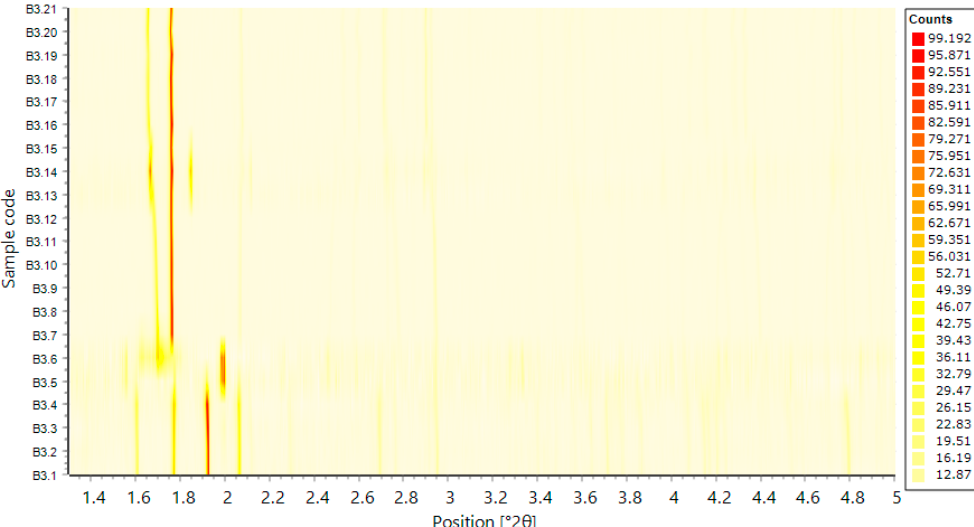
Figure 11. Surface plot of XRPD profiles of HI in the presence of 4-bromoresorcinol corresponding to the P 2 1( γ ) (pH: 4.87 to 5.60), P 2 1( δ ) (pH: 5.60 to 5.71) and P 2 1( β ) (pH: 5.91 to 8.10) polymorphs. The vertical axis corresponds to particular sample codes, the horizontal axis to a specific 2 θ range, while, different colors represent intensities denoting the exact position of diffraction peaks. Data were collected on ID22-ESRF (RT, λ = 1.29989 (3) Å).